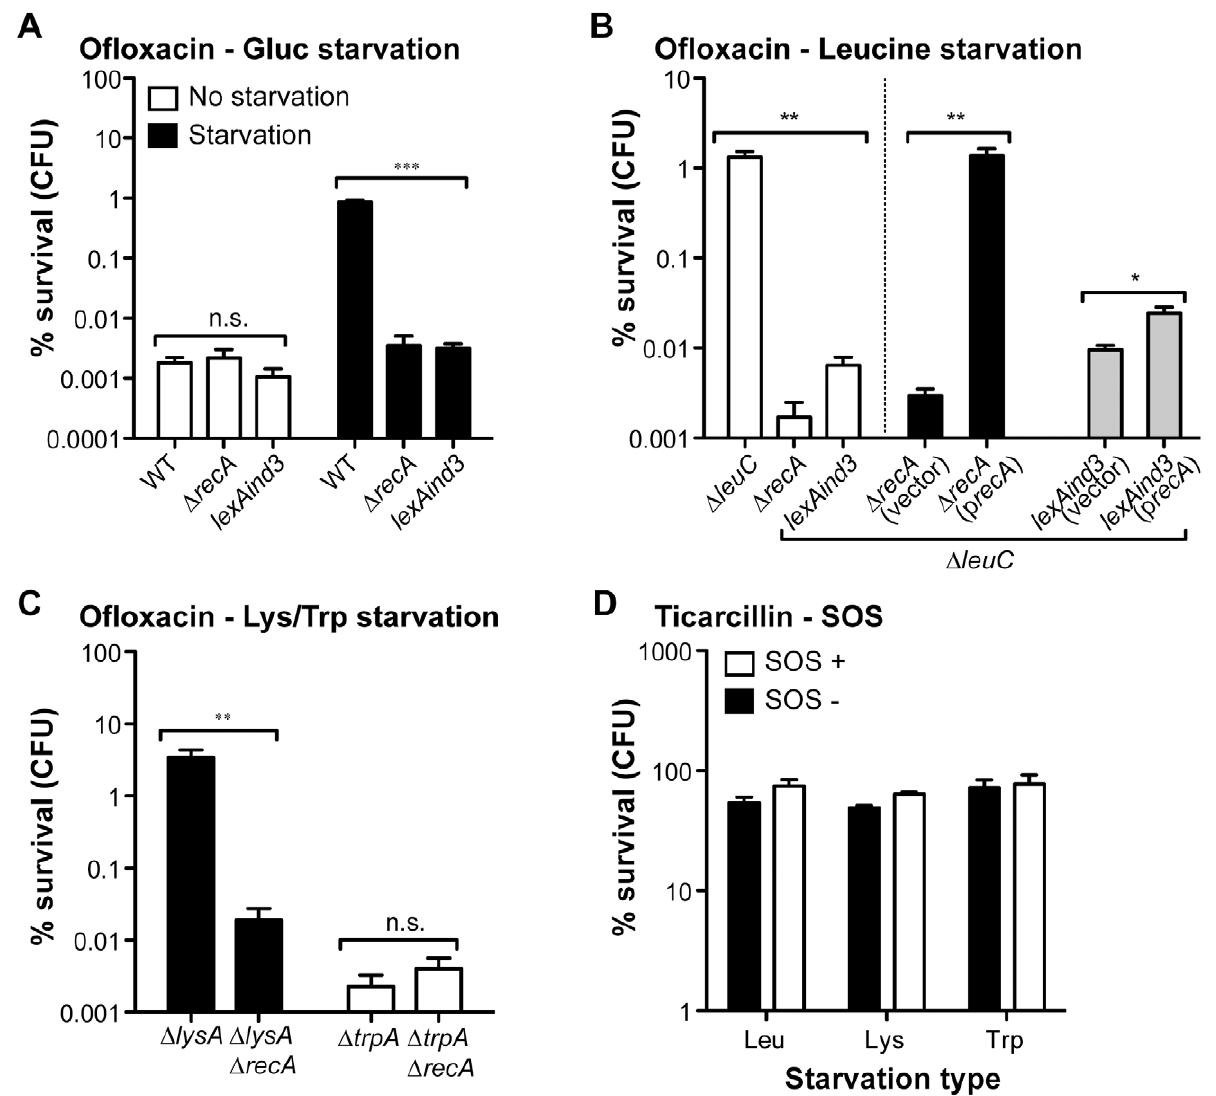
Figure 4. The high ofloxacin tolerance exhibited by starved biofilms is SOS-response-dependent. The impact of SOS response loss-of- function mutations D recA and lexAind3 on the ofloxacin tolerance of starved biofilms for glucose (A), leucine (B), lysine and tryptophan (C). Briefly, all biofilms were grown for 24 h in M63B1 Gluc for all prototrophic strains and with the addition of 25 m g ml 2 1 of leucine, lysine or tryptophan for corresponding auxotrophic strains. All biofilms were treated for 24 h in M63B1 Gluc containing ofloxacin (5 m g ml 2 1 ). For the glucose starvation environment, M63B1 without glucose was used instead of M63B1 Gluc (Panel A - black bars). Ofloxacin hypertolerance of D leuC D recA was not restored when adding the vector control plasmid pAM34 (vector), but complete restoration of high ofloxacin tolerance upon leucine starvation was observed by in trans complementation using pAM34 recA (p recA ). Complementation of D leuClexAind3 with pAM34 recA (p recA ) failed to fully restore ofloxacin hypertolerance back to leucine auxotroph levels. Both pAM34 and pAM34 recA were maintained by the presence of 0.5 mM IPTG. (D) The SOS response mutation D recA (SOS-) did not affect ticarcillin hypertolerance of starved biofilms for leucine (Leu - D leuC D recA ), lysine (Lys – D lysA D recA ) or tryptophan (Trp - D trpA D recA ). Viable cells of the treated biofilm population were quantified by viable cell counts. Percent survival represents the tolerant population after 24 h of treatment compared to untreated biofilm prior to addition of antibiotics. All compared biofilms had similar numbers of CFUs prior to antibiotic treatment (data not shown). Data represented are means 6 SEM of at least three replicates. Asterisks indicate values significantly different by the two-tailed unpaired t test: * P # 0.05, ** P # 0.01, *** P # 0.001, and n.s. (not significant). All strains used here were originally constructed in the WT TG1 genetic background and are detailed in Table S1. The different SOS response mutant strains made in amino acid auxotrophic background are derivatives of D leuC :: D FRT (Leu - leucine), D lysA :: D FRT (Lys - lysine), and D trpA :: D FRT (Trp – tryptophan).